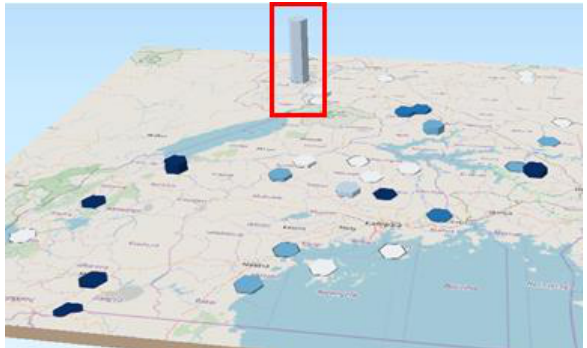
Figure 7. Human settlements "detected" by GL30 for